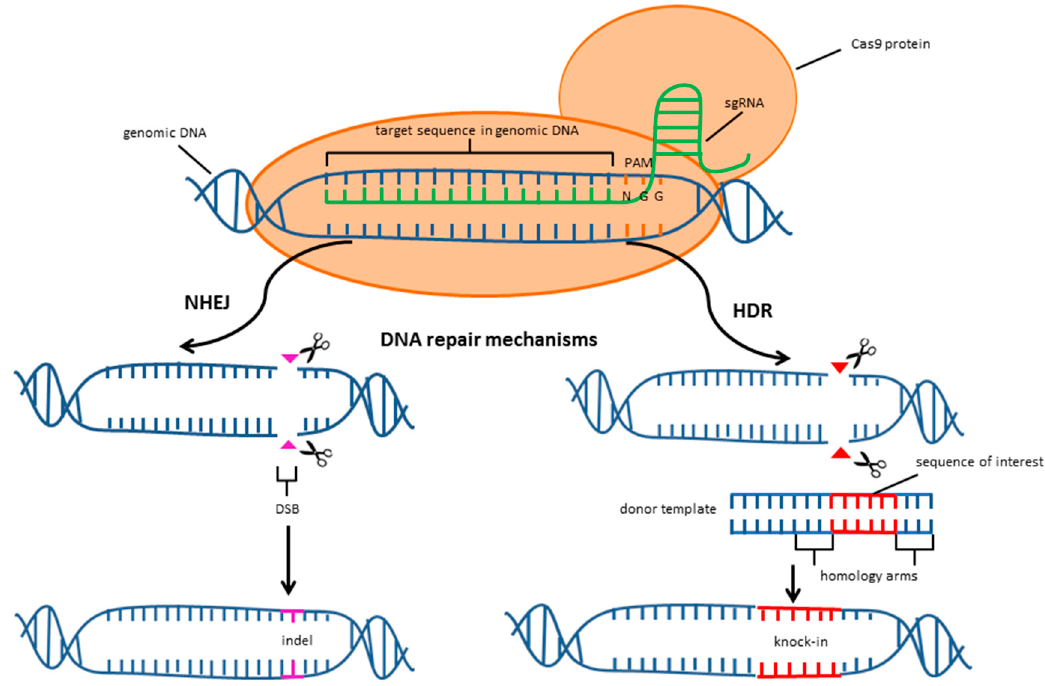
Figure 2. CRISPR/Cas9 mediated cleavage of genomic DNA and two major repair pathways.